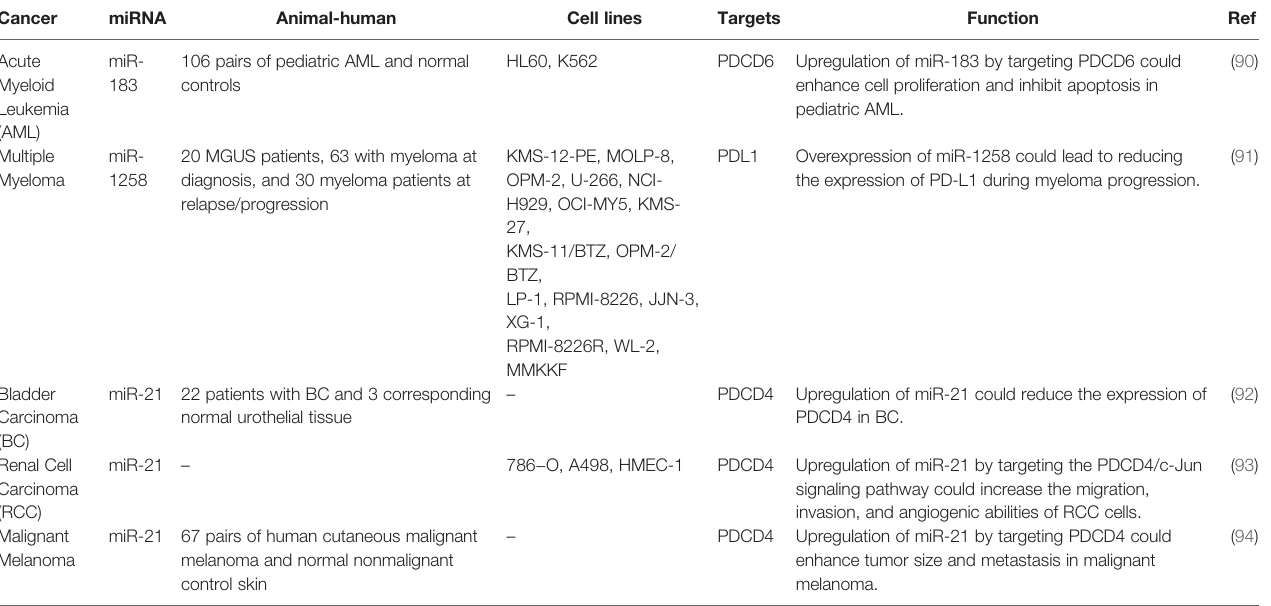
TABLE 9 | Interaction between miRNAs and PDCD in other cancers. Cancer